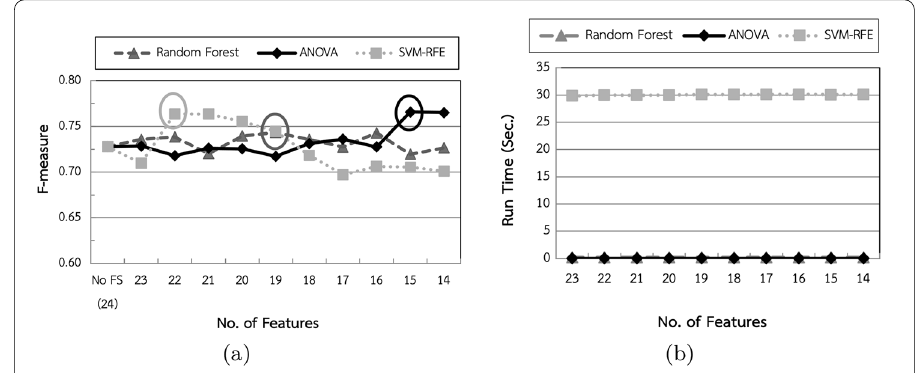
Fig. 6 Feature selection performance: a F-measure; b processing time